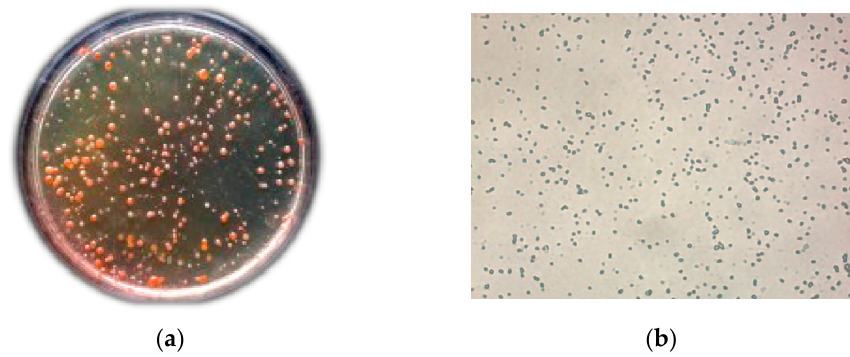
Figure 2. Archaeal colonies on halo-archaeal agar (HAA) and micro morphology of Halococcus sp. AMS12: ( a ) isolated colonies; ( b ) microscopic